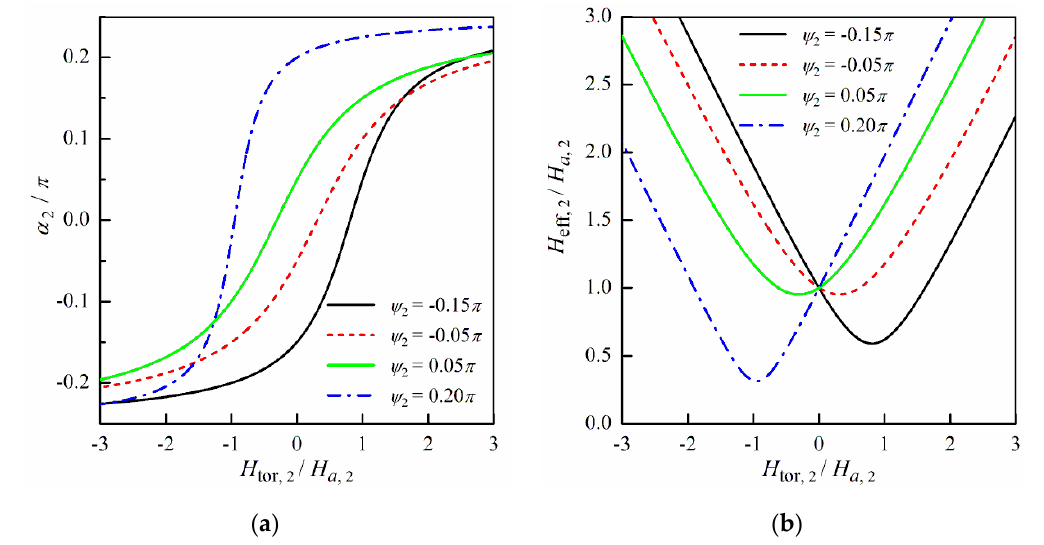
Figure 2. ( a ) The effective anisotropy angle α region as a function of the field H